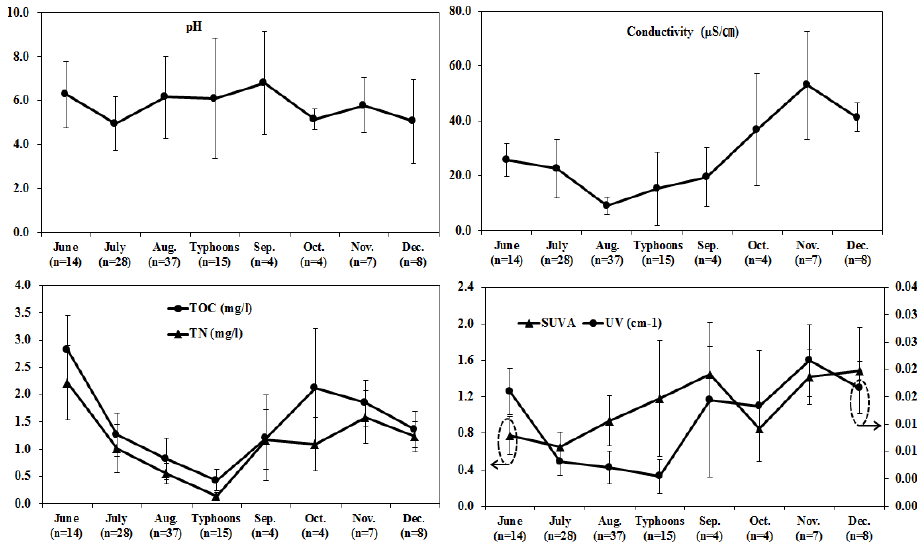
Figure 4. Monthly variation of the volume-weighted mean value of pH, conductivity, TOC, TN, SUVA, and UV absorbance in rainwater samples collected in Gwangju during 2012. Table 3. Correlation matrix between ions in rainwater samples. The Pearson correlation coefficient and the P values are shown. Bold numbers presents R 2 > 0 .